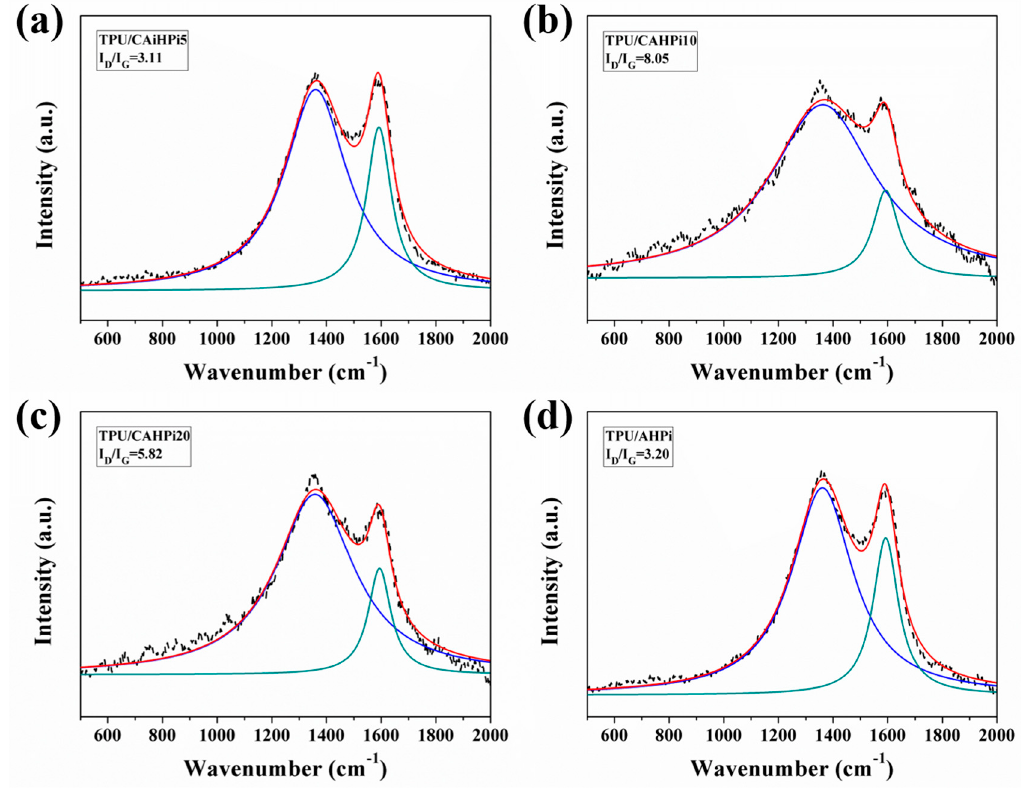
Figure 7. Raman spectra of char residues of ( a ) TPU/CAHPi5; ( b ) TPU/CAHPi10; ( c ) TPU/CAHPi20 and; ( d ) TPU/AHPi. Notes: Black curve represents the real signal; Red curve represents the fitting signal; Blue curve represents the fitting signal at 1350 cm − 1 ; Green curve represents the fitting signal at 1590 cm − 1 .